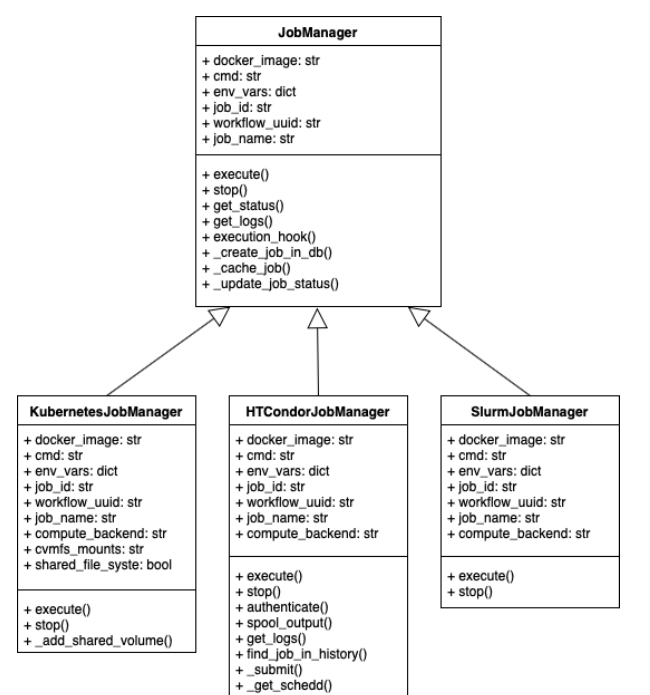
Figure 2. The abstract REANA-Job-Controller component interface designed to allow job execution and monitoring for multiple supported compute backends. [5]